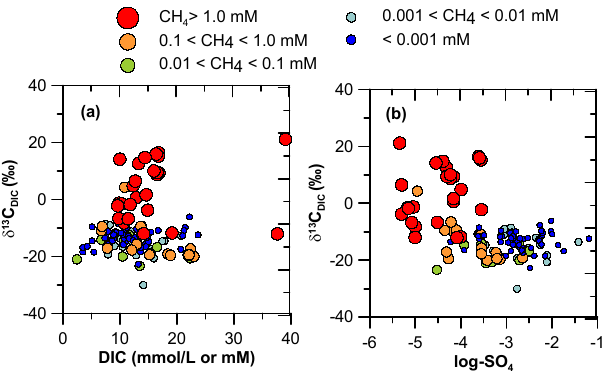
Figure 10. δ 13 C values of DIC and methane concentrations vs. (a) DIC concentrations and (b) sulfate concentrations (log concen-